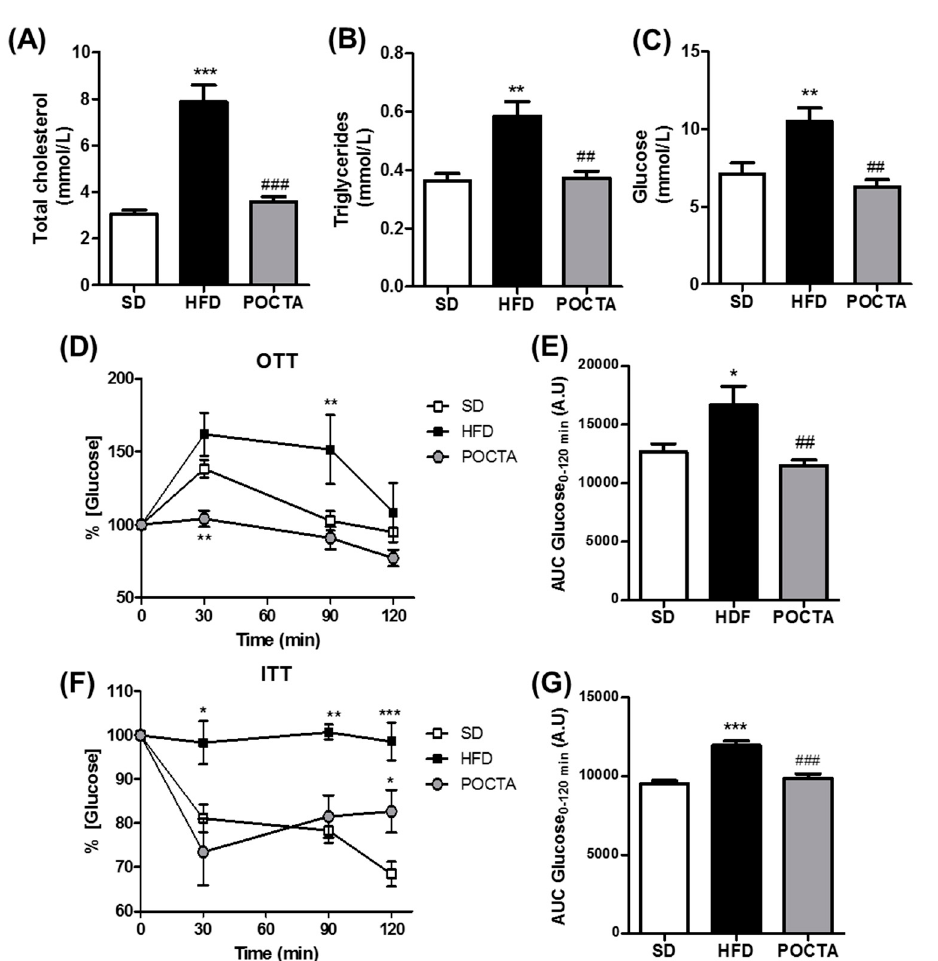
Figure 2. The e ff ect of a POCTA diet on serum cholesterol, triglycerides, glucose, and insulin resistance. Levels of total cholesterol ( A ), triglycerides ( B ), and glucose ( C ) in serum of mice fed the SD, HFD, or POCTA diet. Profile of serum glucose changes obtained from oral glucose tolerance test (GTT) ( D ), and insulin tolerance test (ITT) ( F ), at 20 weeks of treatment. Area under the curve (AUC) results of serum glucose concentrations in the OTT ( E ), and the ITT ( G ). Values are mean ± SEM ( n = 5–7) and are normalized relative to the control group. * p < 0.05, ** p < 0.01, *** p < 0.001 vs. SD; ## p < 0.01, ### p < 0.001 vs. HFD.